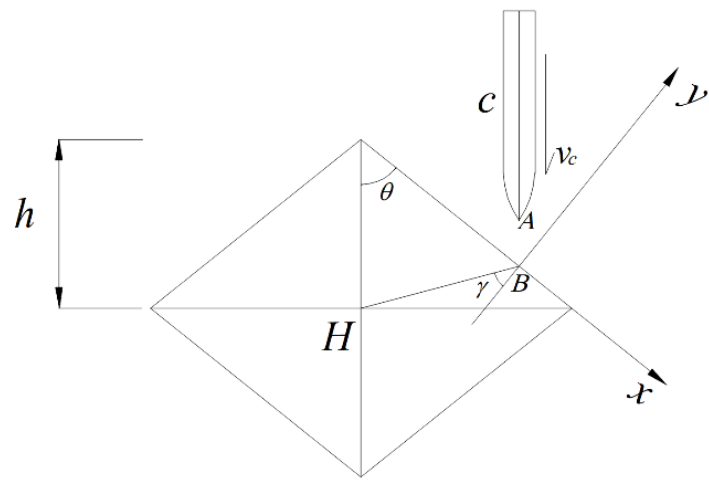
Figure 3. Schematic diagram of kinematic models of the projectile and the moving target before impact.